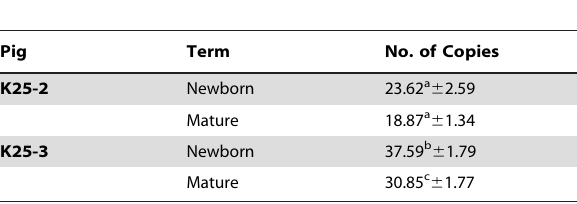
Table 1. GFP copies in newborn and mature founder transgenic pigs.